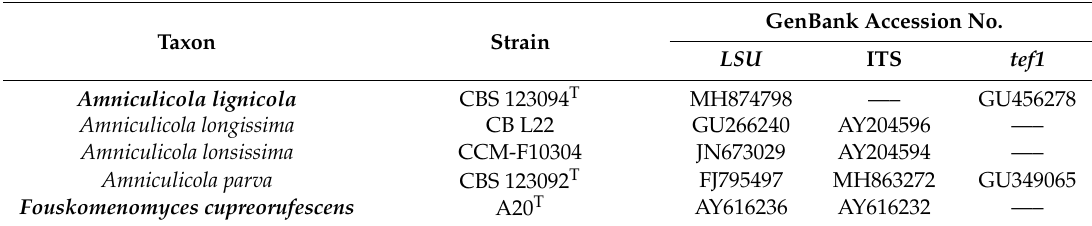
Table 1. Fungal taxa and their nucleotide sequences of the molecular markers used to build the phylogenetic